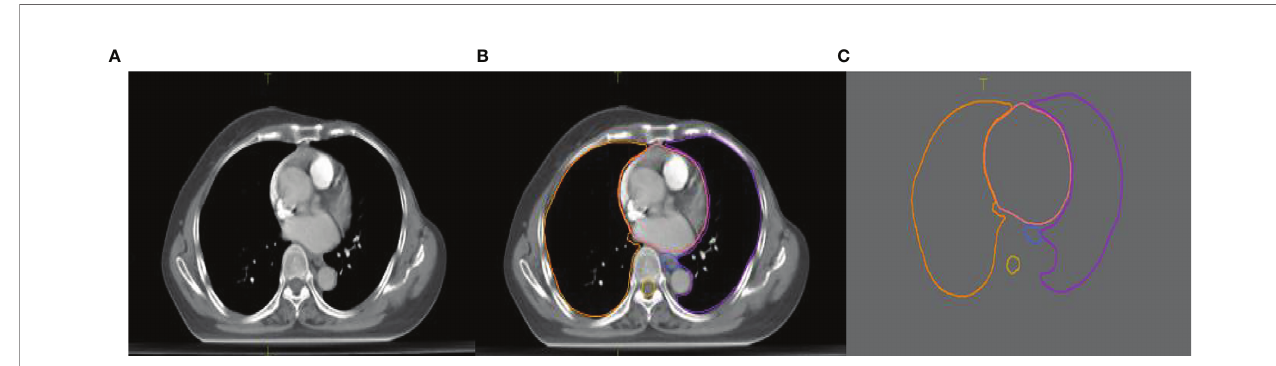
FIGURE 1 | Images of a lung patient in the experimental data. (A) is the original axial slice image of CT scan; (B) is the axial slice image of CT scan delineated by the physician; (C) is the contour of delineated organs extracted